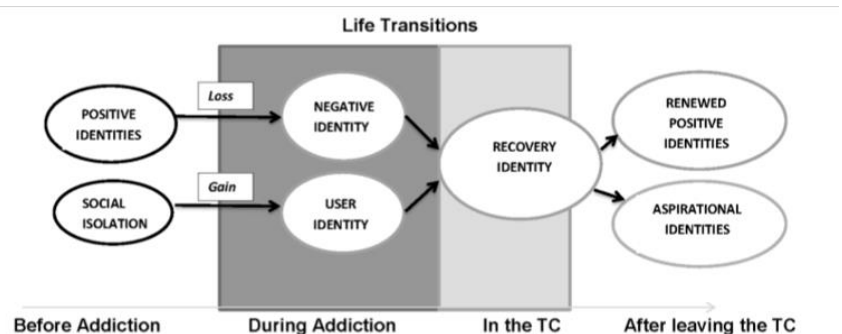
Figure 2. Diagram of page 5 of Dingle’s “Social Identities as Pathways”.